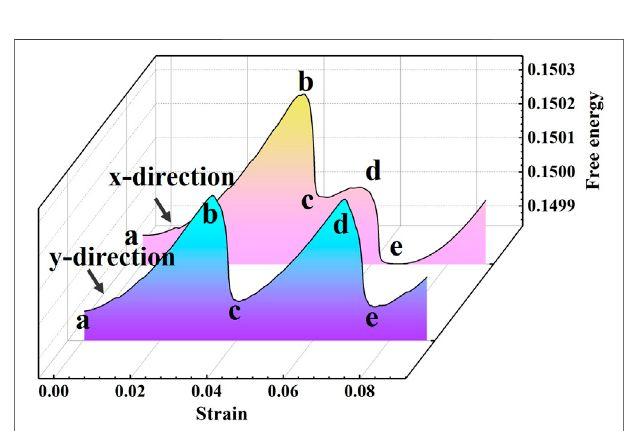
FIGURE 7 | Free energy curve of misorientation angle of 7 ° under x -and y -direction tensile deformation.